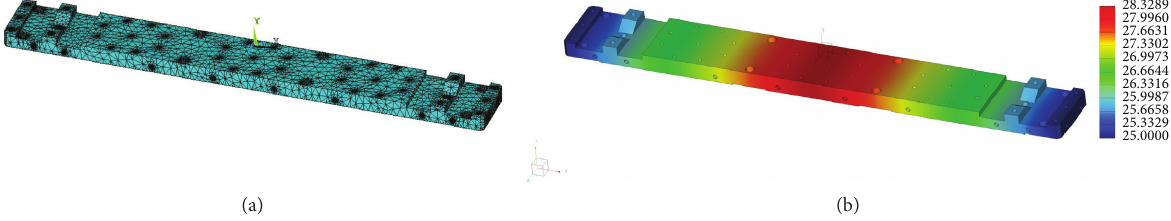
Figure 8: Thermal deformation finite element analysis of the ring-down cavity. (a) Finite element meshing of the base plate. (b) Temperature distribution of the bottom plate when the temperature changes to 28 ° C (25 ° C at room temperature).